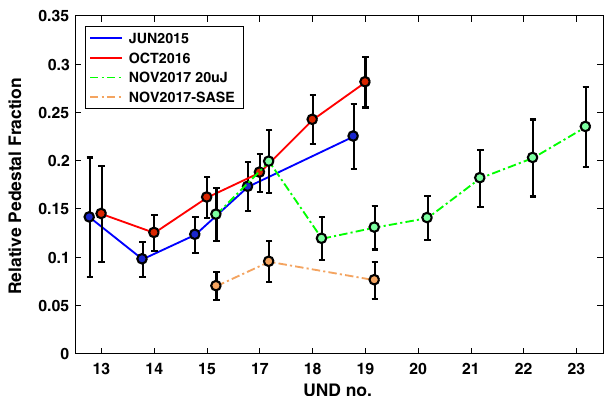
FIG. 8. Pedestal region strength normalized to that of total emission as a function of undulator position. The Nov. 2017 SASE data are normalized to the total emission of the corre- sponding self-seeded dataset obtained at the same LH 20 μ J energy. The error bars refer to RMS